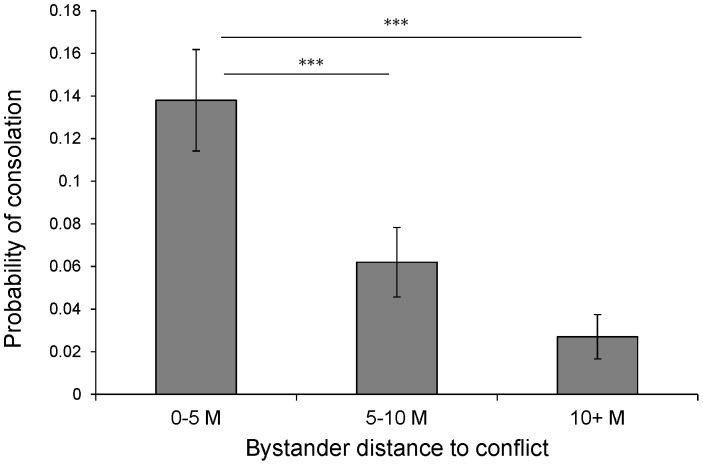
The probability of providing consolation as a function of the bystander proximity to the conflict.Bar chart indicated means+SD. Asterisk indicates P<0.001.